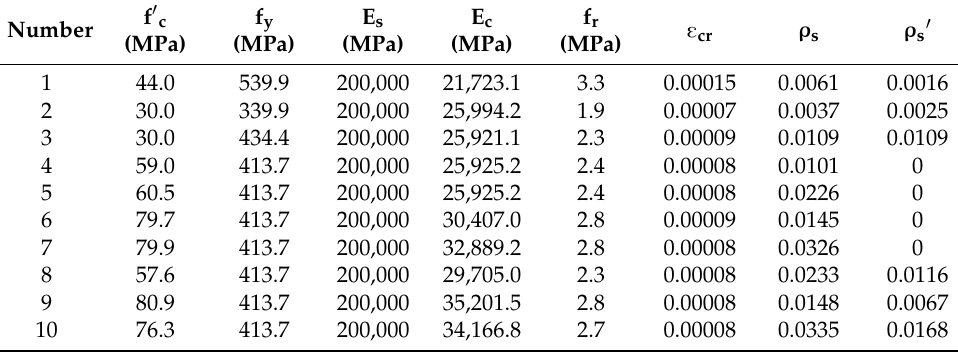
Table 3. The material parameters for the tested